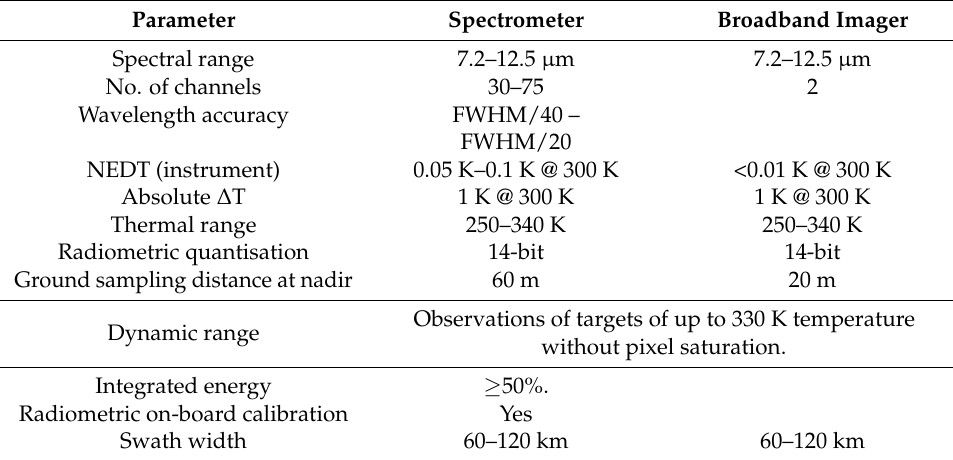
Table 1. Proposed technical TIR spectrometer and imager